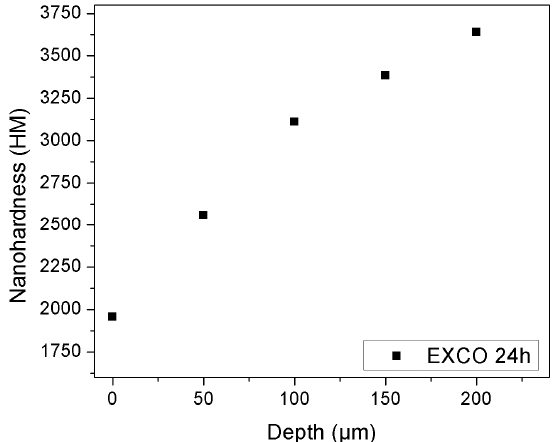
Figure 3. Nanoindentation hardness evolution, per distance, from the pit bottom after 24 h in Exfoliation Corrosion (EXCO) solution.